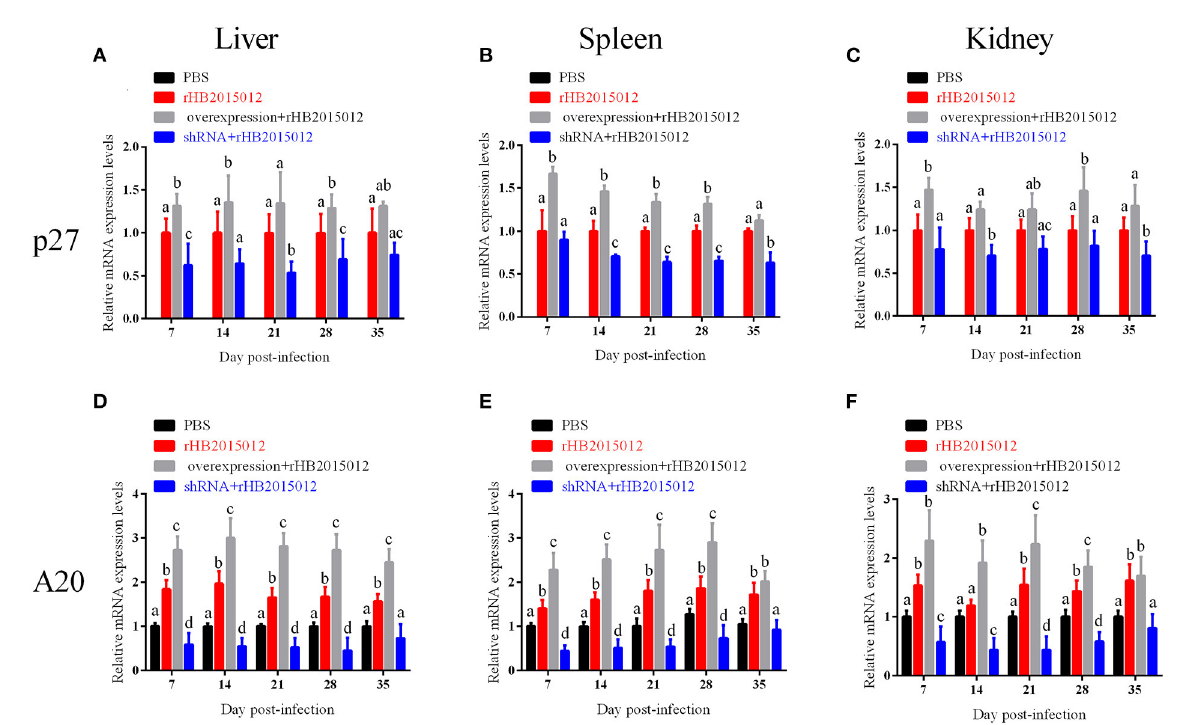
FIGURE9 The viral loads in liver, spleen and kidney after ALV-A infection was determined by q-PCR. (A–C) Liver, spleen, and kidney viral loads. (D–F) Expression of A20 in liver, spleen, and kidney. a, b, c, and d indicate differences, with the same letter indicating no difference and different letters indicating a